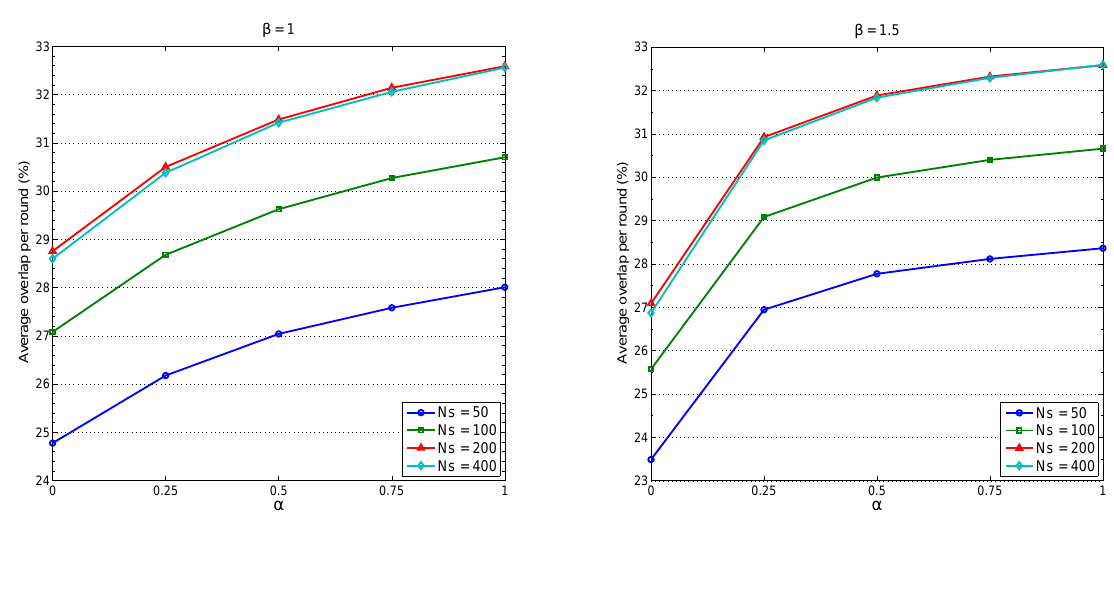
Figure 11. Average sensing overlap per round versus α with β = 1 . 0 (left) and with β = 1 . 5